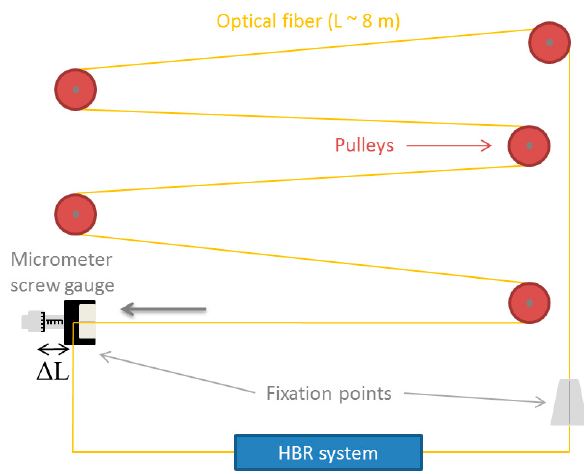
Figure 2. Schematic representation and picture of the strain calibration device.